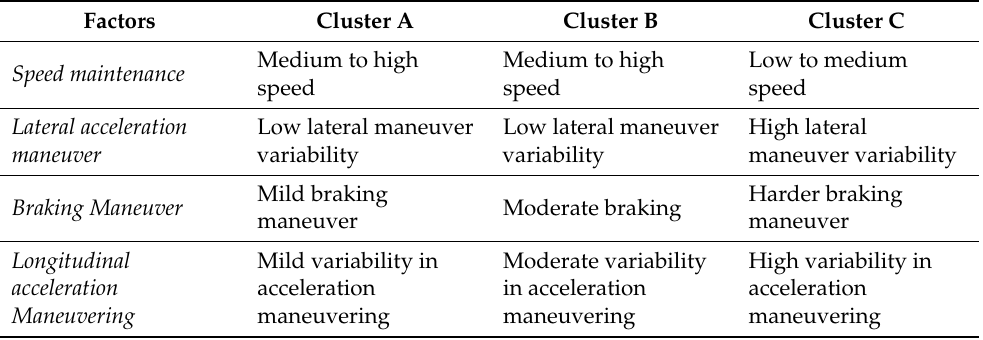
Table 3. Interpretation of driving styles of each cluster. (Adapted from Chen, K.-T.; Chen, H.-Y.W. Driving Style Clustering Using Naturalistic Driving Data. Transp. Res. Rec. J. Transp. Res. Board 2019